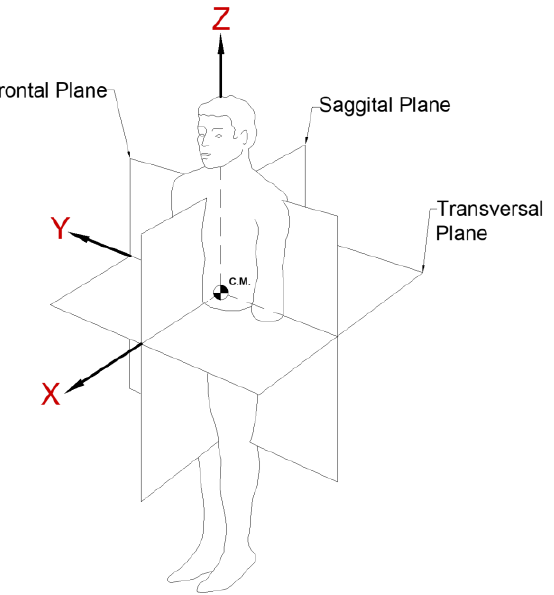
Figure 2. Generalized spatial coordinate system.